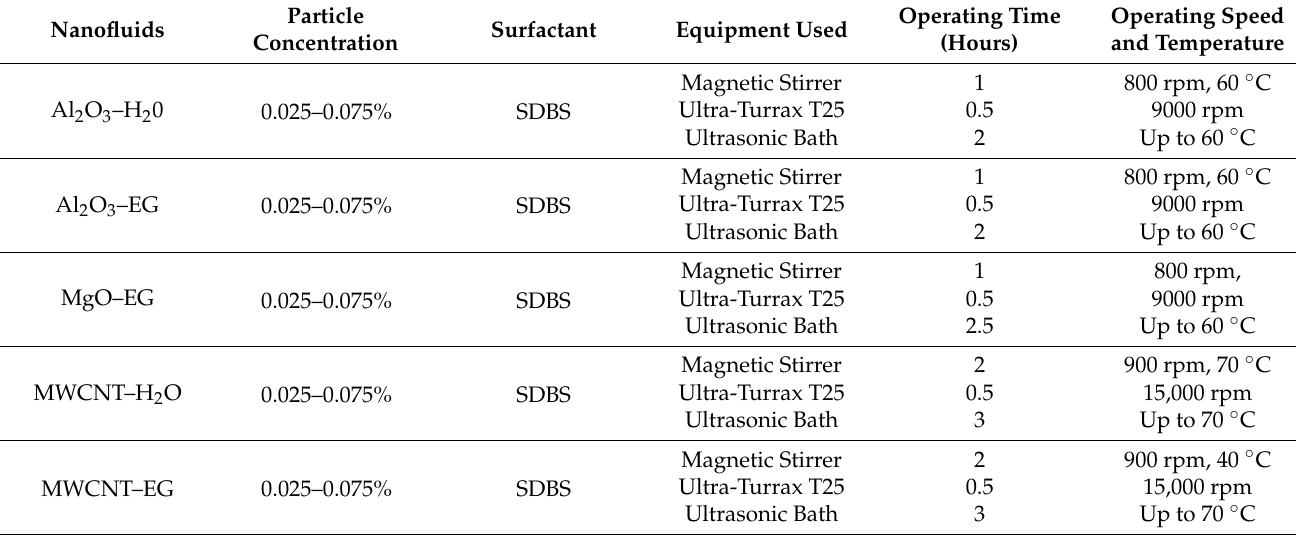
Table 5. Nanofluid sample preparation